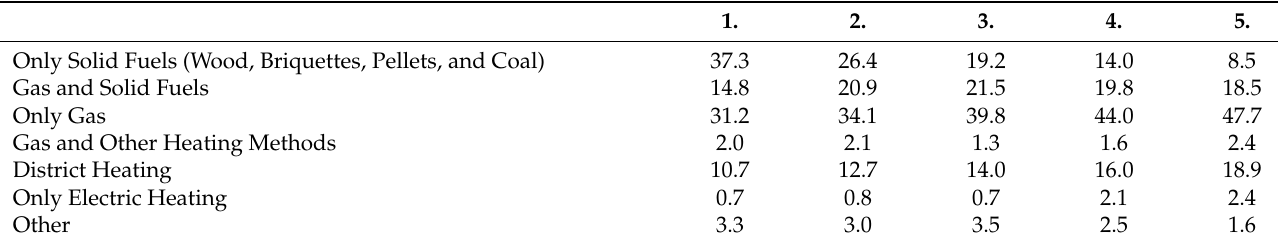
Table 1. Share of households by source of heating by income quintiles percentage (2019).